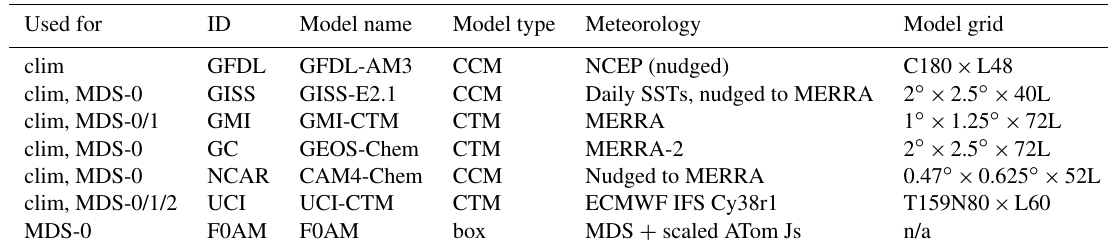
Table 1. Chemistry models.